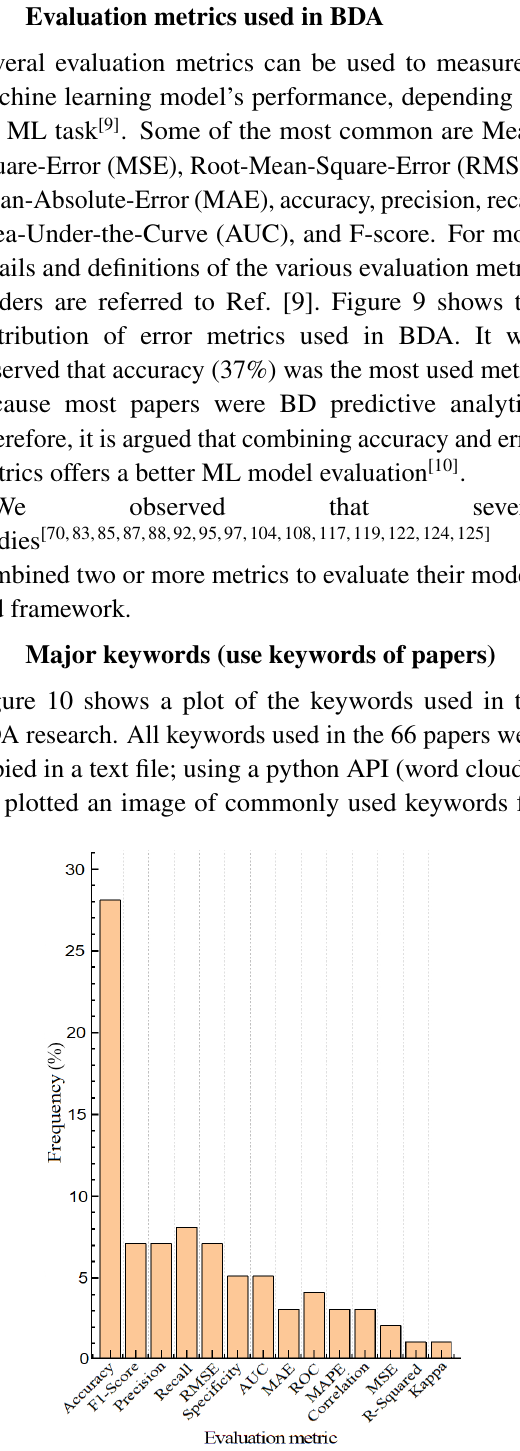
Fig. 9 Evaluation metric